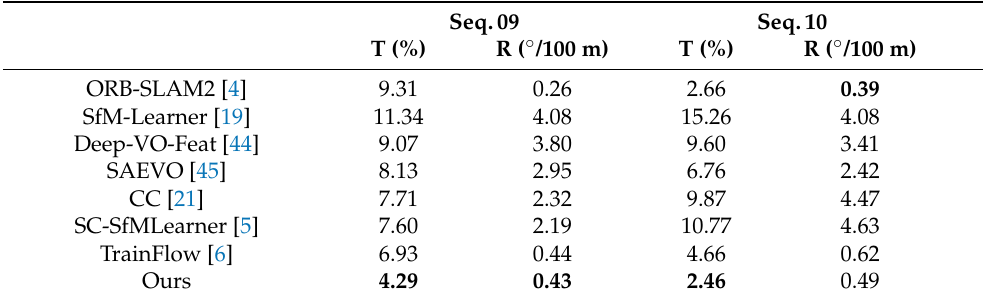
Table 2. Compared with recent works, our method produced fairly good camera pose prediction in a normal-motion scene (stride = 1). ORB-SLAM2 contained no loopback detection.